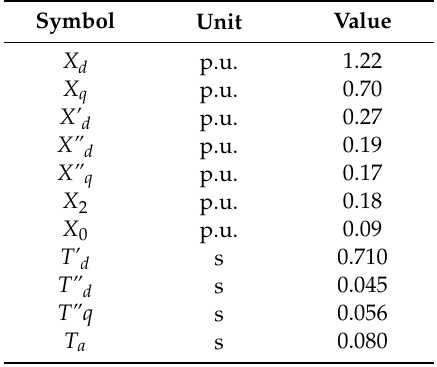
Figure 3. Comparison of measured curves with those calculated for no-load ( a ) and three-phase short circuit ( b ). Table 4. Computed reactances and time constants of the investigated